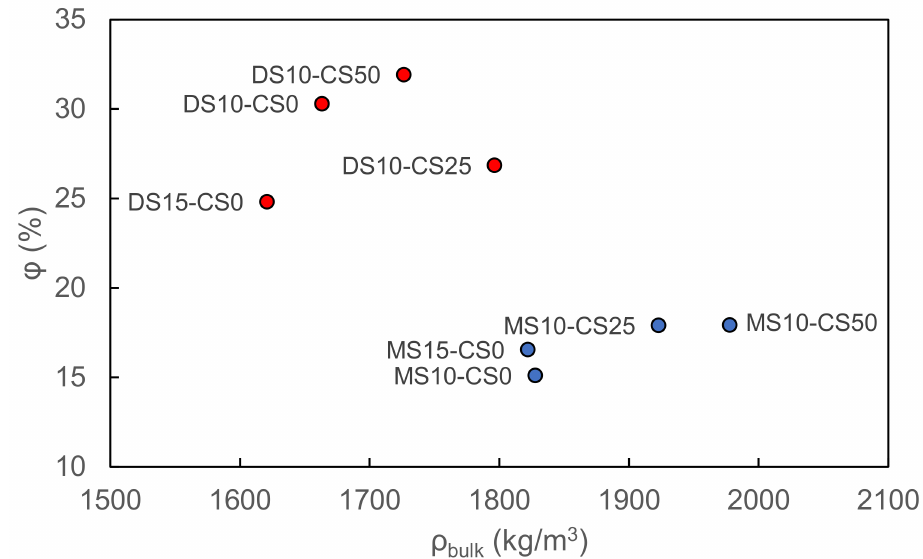
Figure 7. The porosity vs. bulk density of metasilicate and disilicate samples (2) DS10-CS0 and MS10-CS0, (3) DS15-CS0 and MS15-CS0, (8) DS10-CS50 and MS10-CS50 and (9) DS10-CS25 and MS10-CS25 (see Table 2 for mix design) based on vacuum saturation.